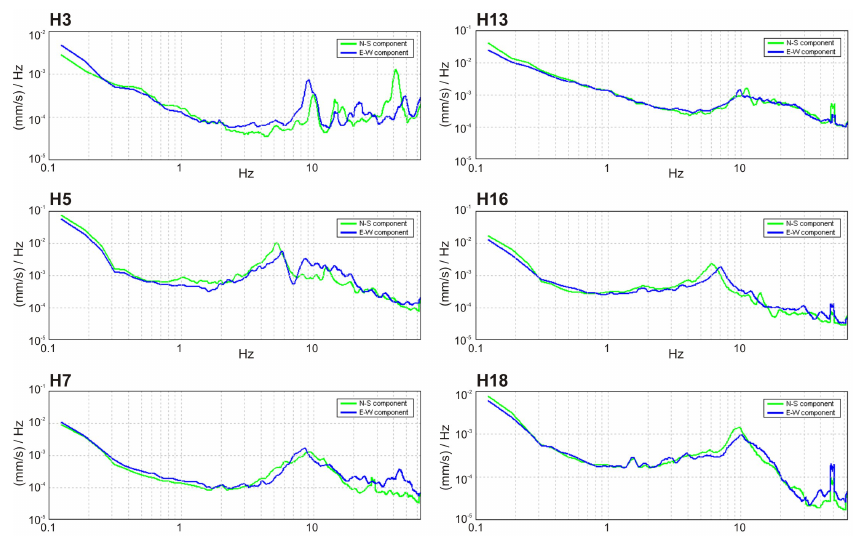
Fig. 8. Amplitude spectra of microtremor measurements inside six examined buildings. Their locations are shown in Fig. 6. Green line represents longitudinal direction and blue line transverse direction of the building.